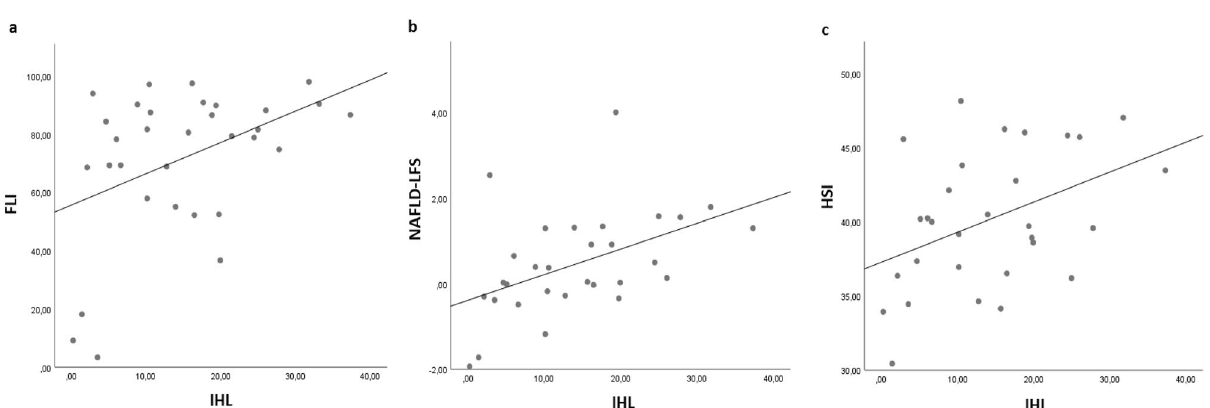
Figure 2. Correlation analysis between liver fat indices and IHL at baseline; FLI = fatty liver index, HSI = Hepatosteatosis Index, IHL = intrahepatic lipids, NAFLD-LFS = non-alcoholic fatty liver disease-liver fat score; ( a ) IHL ~ FLI; rho = 0.351. p = 0.049; ( b ) IHL ~ NAFLD-LFS; rho = 0.537, p = 0.002; ( c ) IHL ~ HSI; rho = 0.393, p =